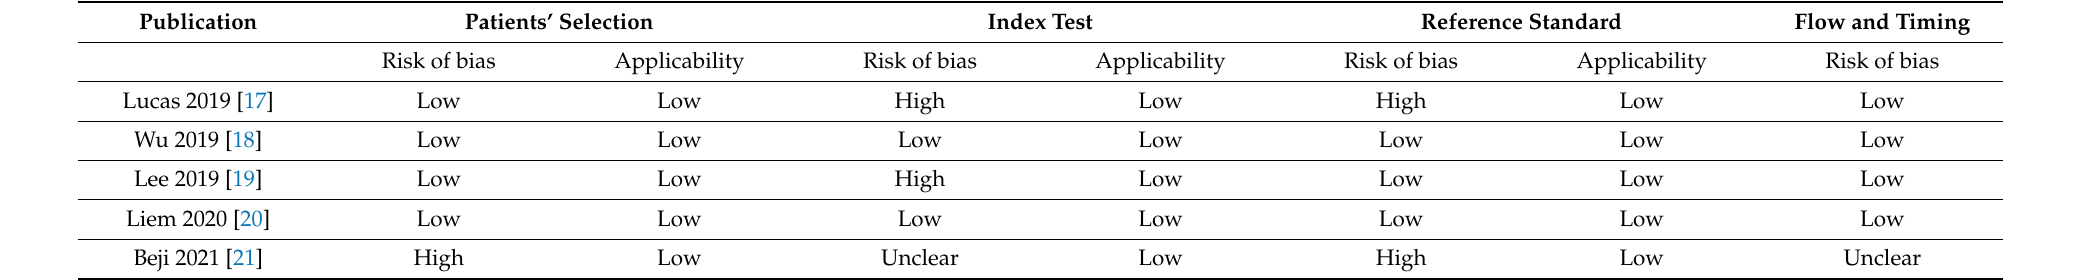
Table 1. Risk-of-bias assessment according to Quadas-2 criteria [11].